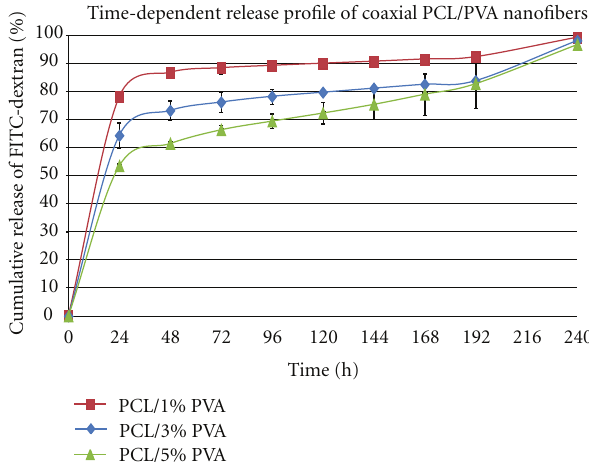
Figure 5: Time-dependent release profile of coaxial PCL/PVA na- nofibers. Release of FITC-dextran from samples with di ff erent con- tent of PVA core was analyzed using fluorescence spectroscopy. Samples were analyzed for 240 h, and supernatants were collected in 24h intervals (mean ± standard